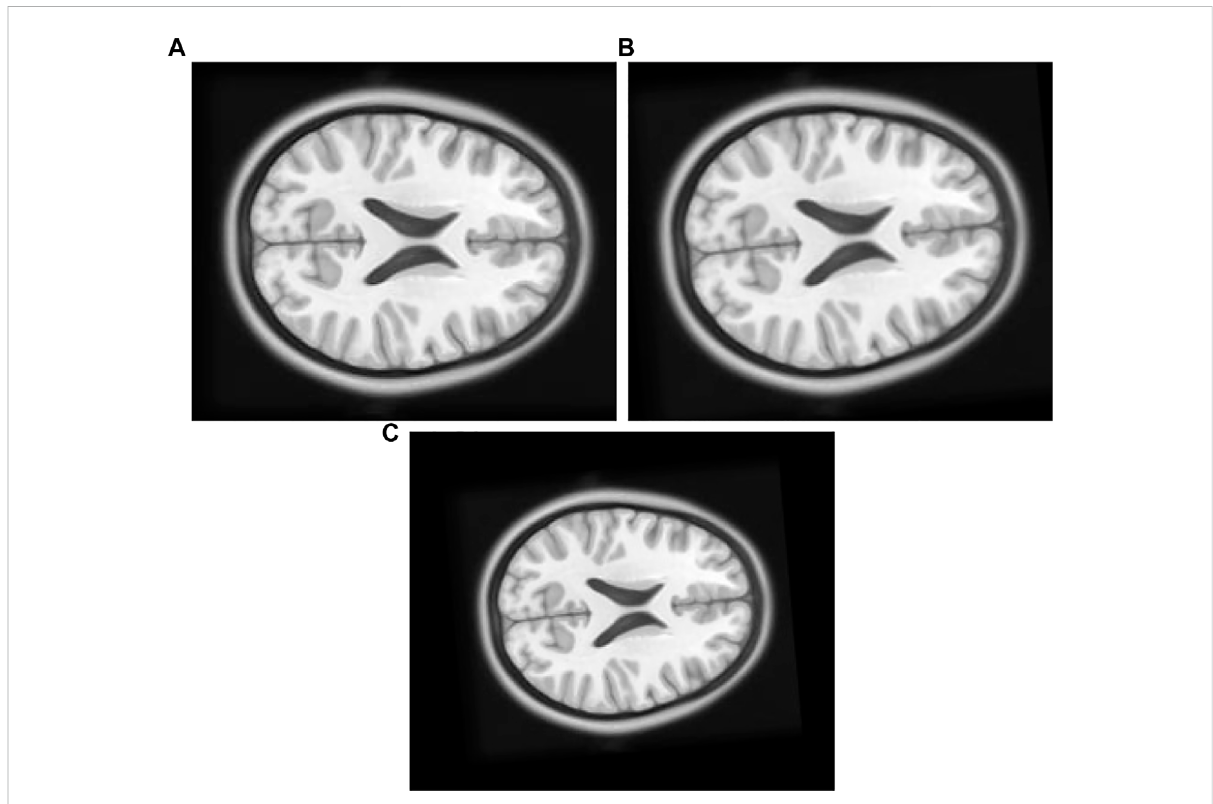
FIGURE 7 (A) Original Image: row fi rst left. (B) Float Image Unscaled: row fi rst right. (C) Float Image Scaled: second row